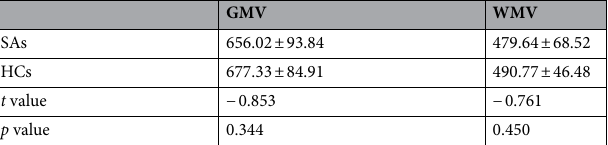
Table 3. Comparison of whole brain volume between SA and HC group. SA strabismus with amblyopia, HC healthy control, GMV gray matter volume, WMV white matter volume.